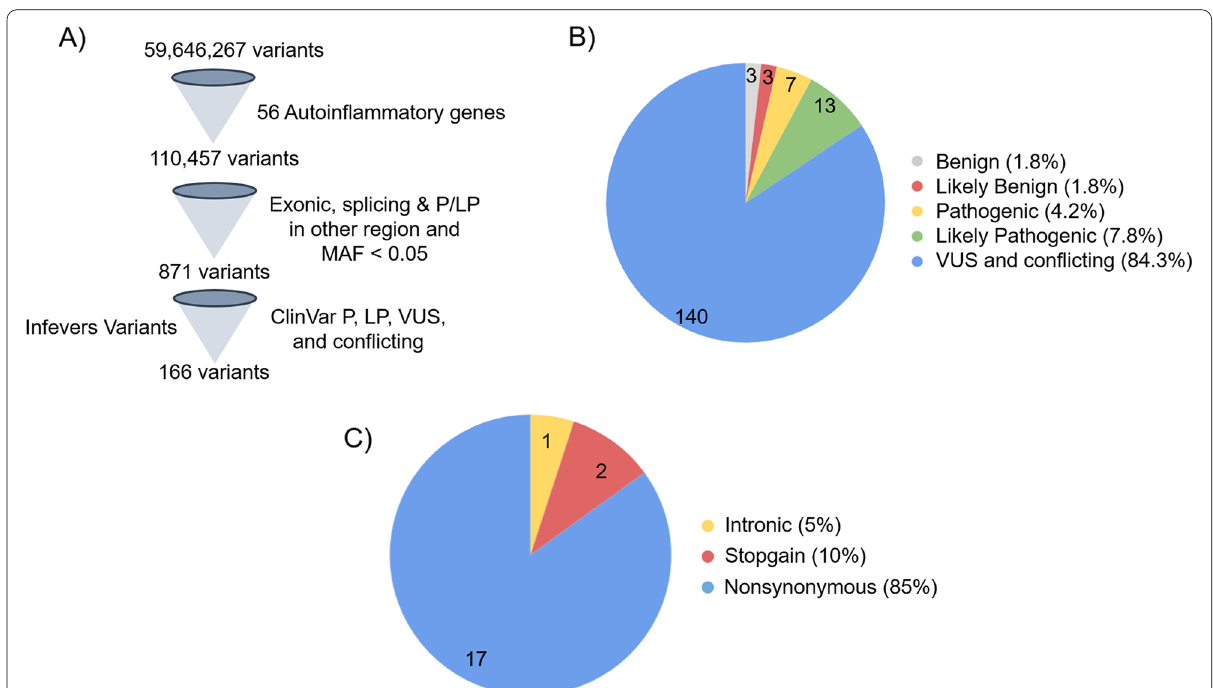
Fig. 2 Variant filtering and classification based on ACMG-AMP guidelines. A Variant prioritization for ACMG classification. B Variant classification based on ACMG-AMP guidelines. C Pathogenic and likely pathogenic variants classification based on the type of